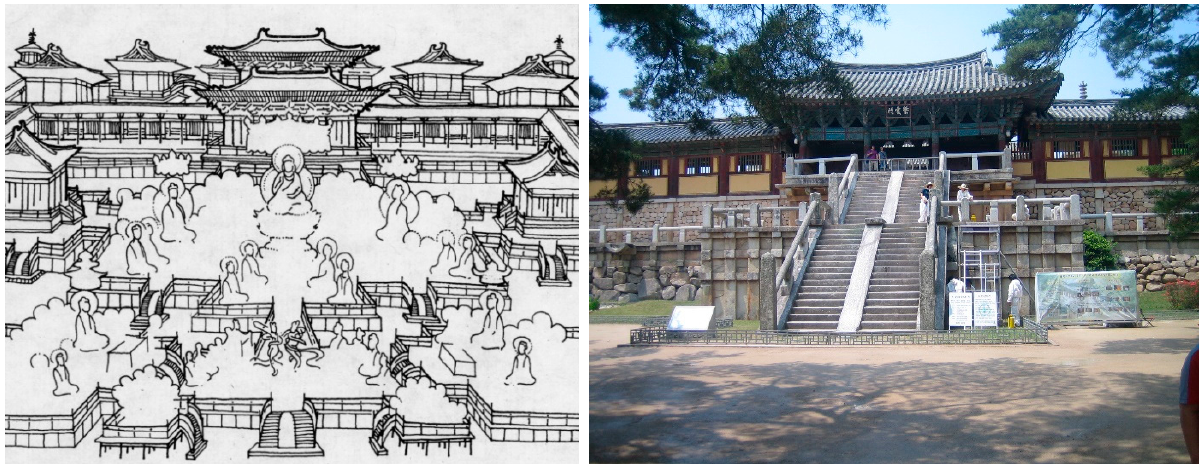
Figure 11. The upper-lower grand terraced platforms with a central stairway at Bulguksa ( Right , photo by author) and multi-terraced wooden platform at Dunhuang Cave 148, the Western Amitabha Paradise, Mid Tang ( Left , source: Xiao Mo).